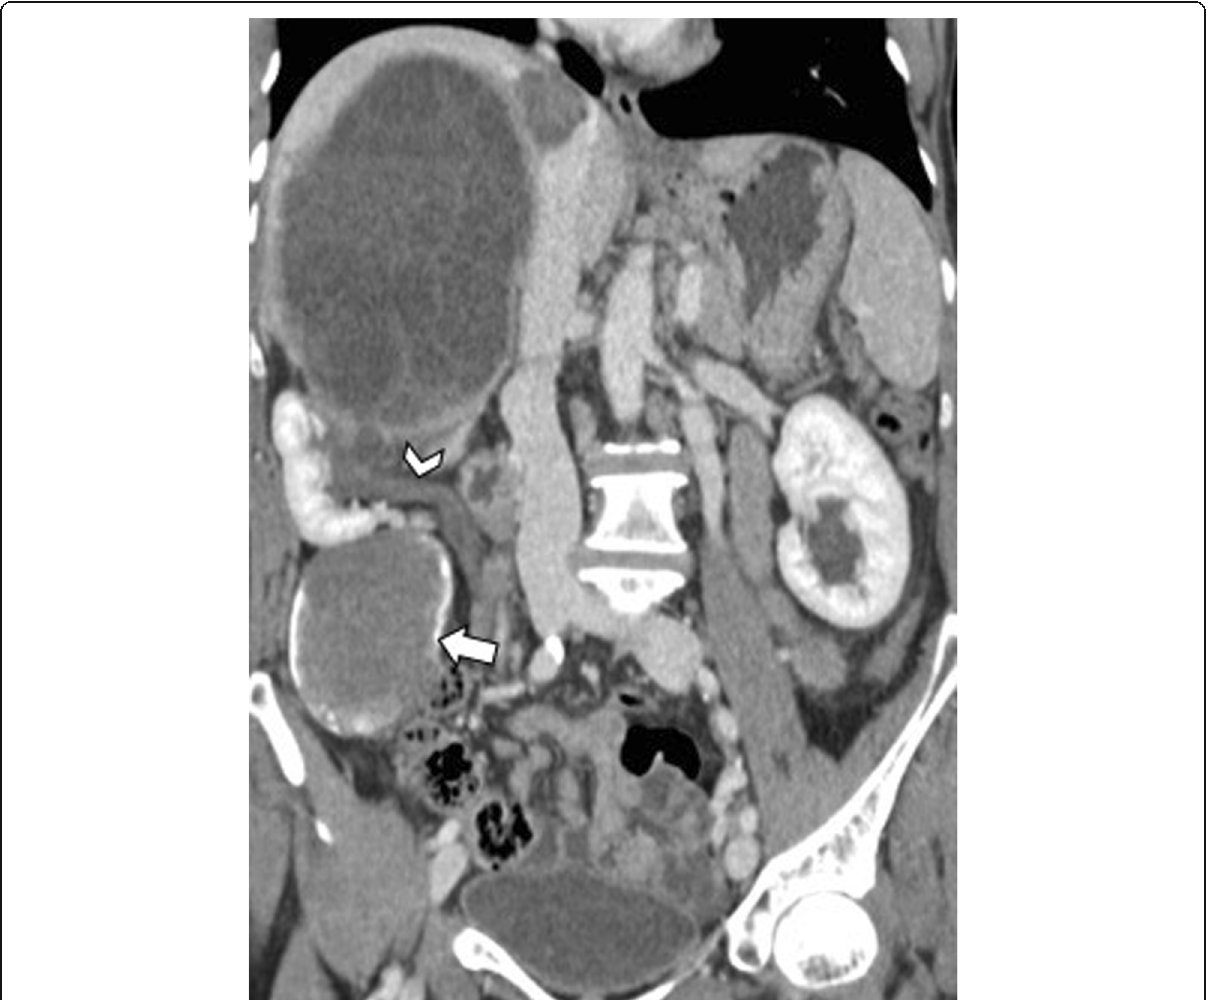
Fig. 16 A 60-year-old woman with large partially exophytic hepatic hydatid cyst. Coronal reformatted CT image on portal venous phase shows a large hepatic hydatid cyst with multiple daughter cysts, associated with peritoneal hydatid cysts (arrow). The exophytic growth of the hepatic hydatid cyst causes significant mass effect on the right kidney, which appears compressed and dislocated with hydronephrosis